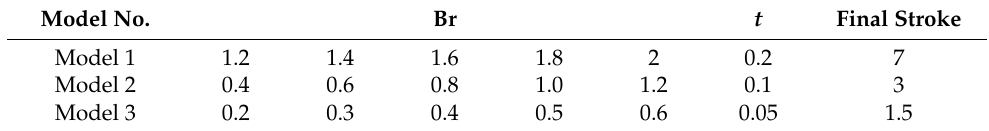
Table 6. The fillet radius and related parameters of the hole in the stainless steel sheet (unit: mm). Model No. Br t Final Stroke Model